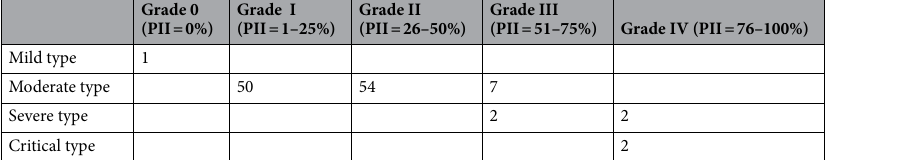
Table 4. Clinical classification corresponding to the grade of maximum